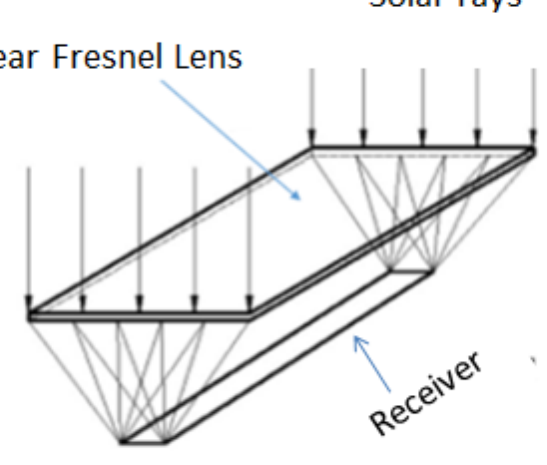
Figure 10. Linearly shaped Fresnel lens proposed by Wang et al. [18]. Reprinted from G. Wang et al., Design and optical analysis of the band-focus Fresnel lens solar concentrator. Applied Thermal Engineering 2016, 695–700, with permission from